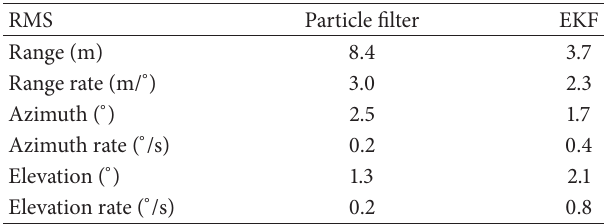
Table 1: PF performance in the selected scenario in terms of RMS error.